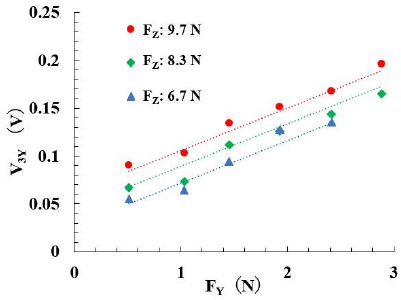
Figure 12. Relationship between tangential force F Y and ∆ V 3Y . The measurement results were plot on different straight lines for each F Z , but the slopes of the straight lines were the same.